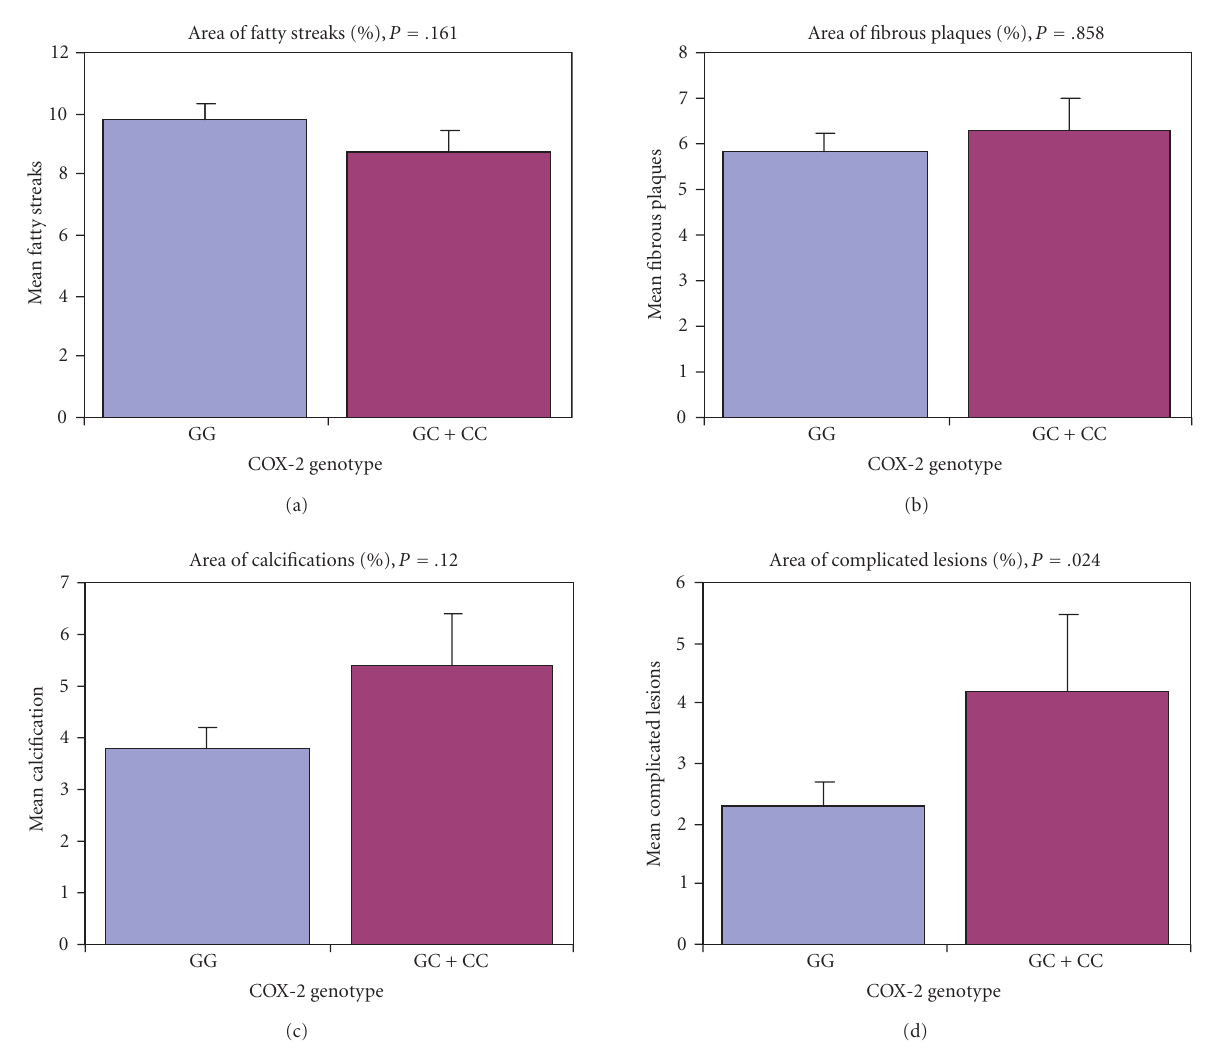
Figure 1: Association of COX-2 genotype with atherosclerotic changes. P values are from ANCOVA with age and BMI as covariates. Error bars represent